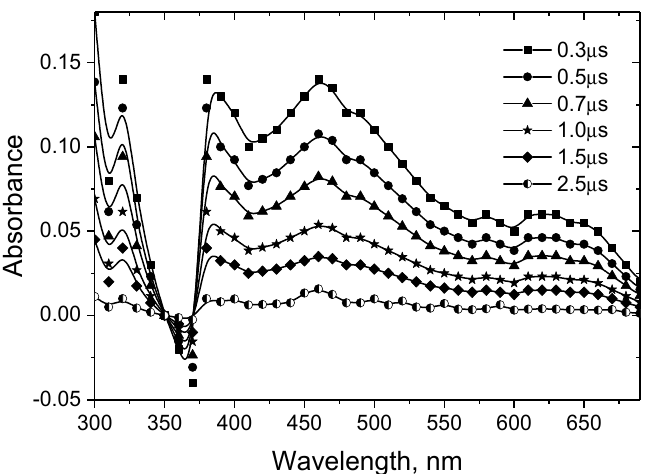
Figure 5. Laser flash photolysis spectra of the dye FN2 in acetonitrile recorded after irradiation with laser pulses of 355 nm. Delay times shown in legends.